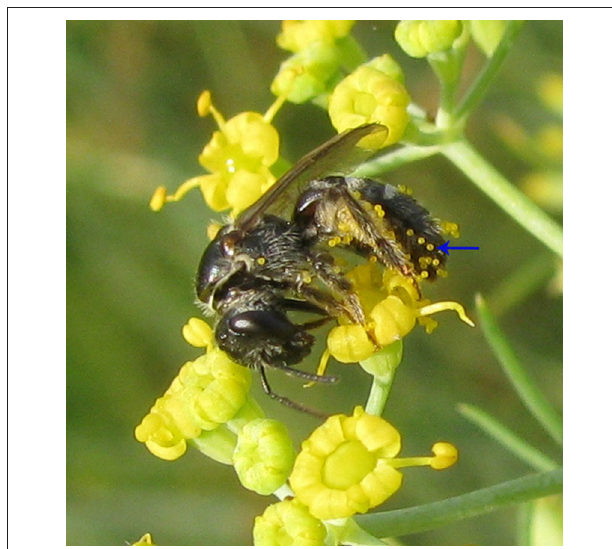
FIGURE 1 | Halictus acrocephalus visiting fennel flowers with other type ( Cucurbita maxima ) of pollen grains on the body surface.